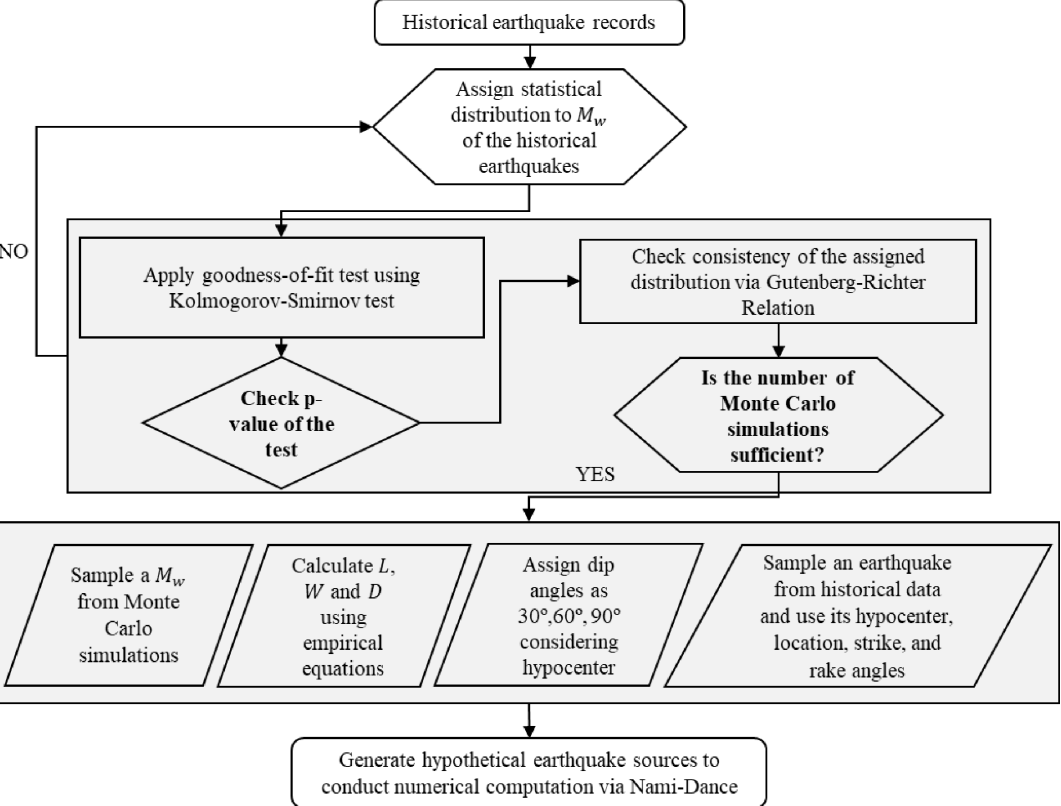
Figure 5. Generation steps of the hypothetical earthquake sources.